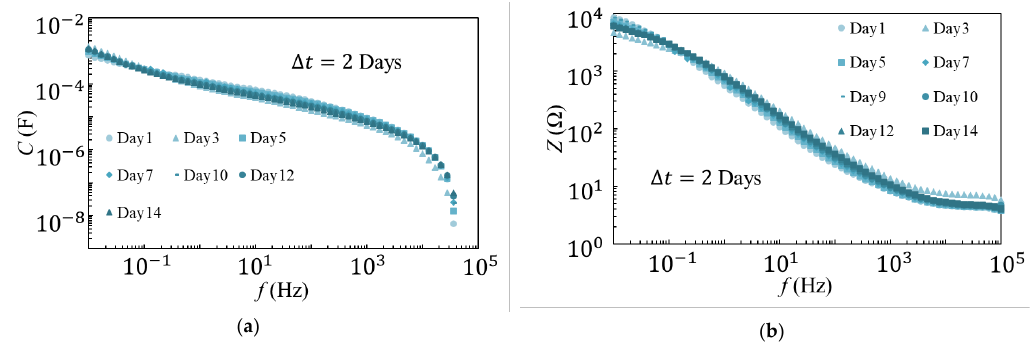
Figure 6. C ( a ) and Z ( b ) measured at 80 °C in variable temperature (80–5 °C) degradation tests.